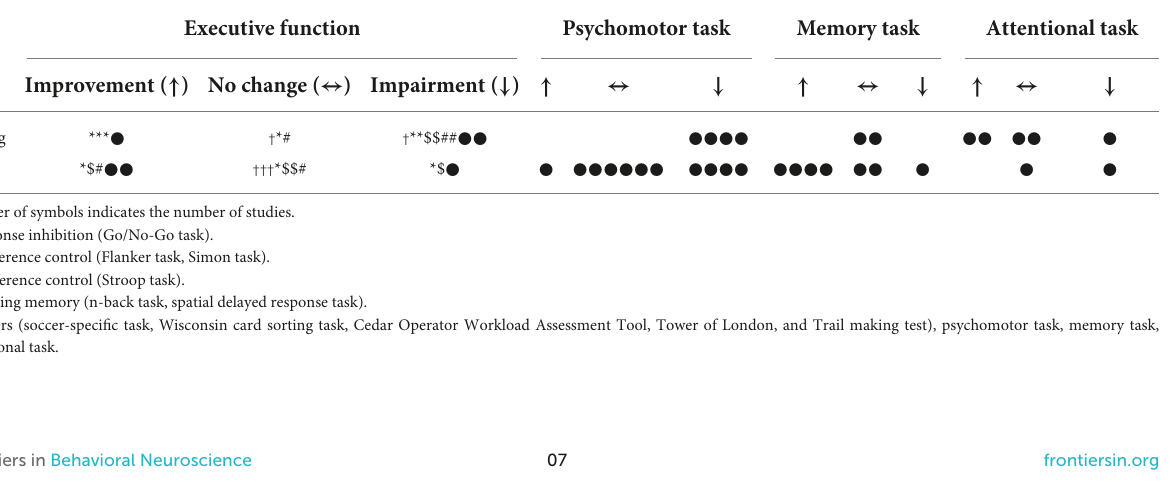
TABLE 3 Summary of impacts of the type of cognitive